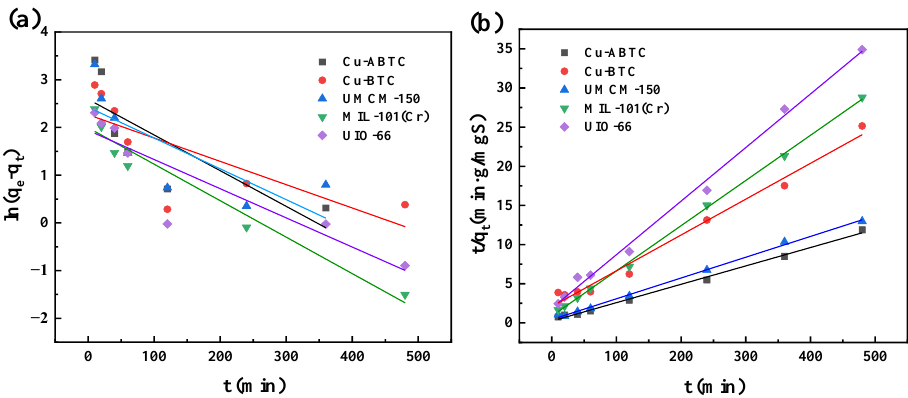
Figure 5. Kinetics of DBT adsorption onto the five MOFs fitted by ( a ) pseudo-first-order and ( b ) pseudo-second-order. Table 2. Parameters of the kinetic model.